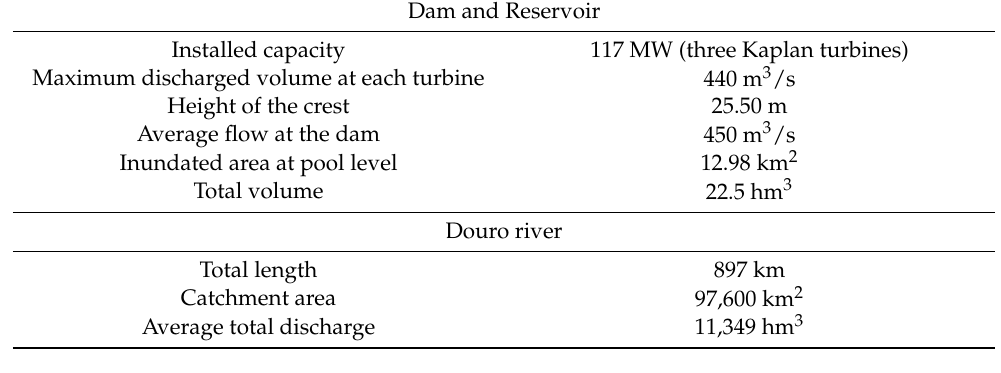
Table 1. Main characteristics of the Crestuma-Lever dam/reservoir and the Douro River. Data sources: dams in Portugal (h tt ps://cnpgb.apambiente.pt/gr_barragens/gbportugal/Crestuma.htm (accessed on 30 January 2022)) and Douro River basin management plan (h tt ps://www.apambi- ente.pt/node/1598 (accessed on 30 January 2022)).